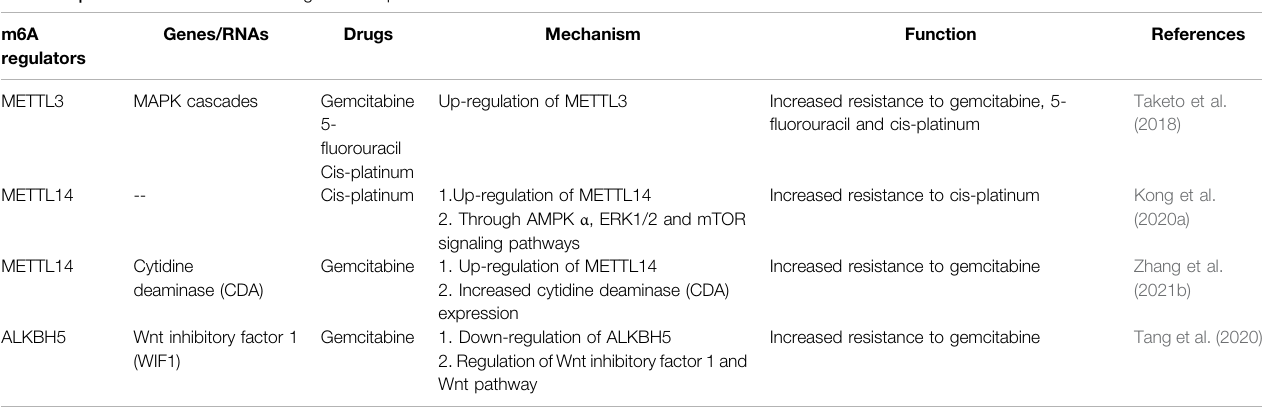
TABLE 2 | The roles of different m6A regulators in pancreatic